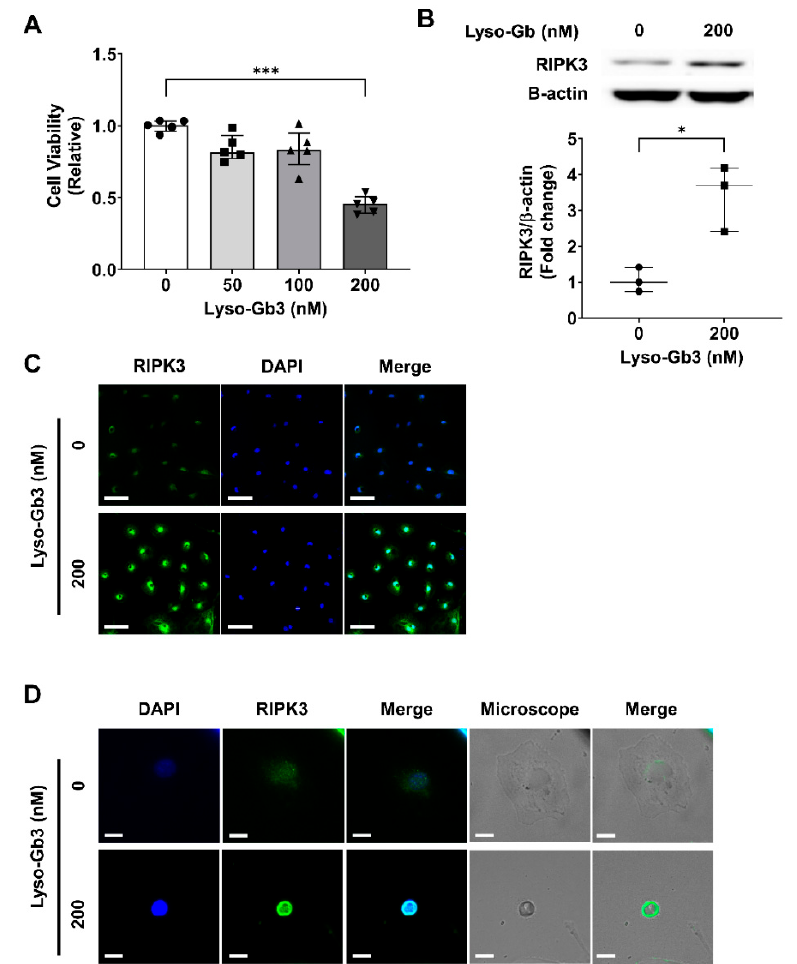
Figure 1. Lyso-Gb3 induced podocyte death via a RIPK3-dependent pathway in mouse podocytes. ( A ) MTT assay for cell viability. Mouse podocytes were treated with lyso-Gb3 for 24 h. Cell viability was reduced significantly in a dose-dependent fashion ( N = 5, median with interquartile range). *** p < 0.001 versus control by the Kruskal–Wallis test with Dunn’s post-hoc analysis. ( B ) Representative Western blot assay ( top ) and densitometric quantification of RIPK3 levels (normalized to β -actin levels) ( bottom ). RIPK3 levels were increased by treatment of Lyso-Gb3 (200 nM) in mouse podocytes ( N = 3, median with interquartile range). * p < 0.05 versus control using the Mann–Whitney test. ( C , D ) Immunofluorescence staining for RIPK3 (green) and DAPI (blue). ( C ) Representative images of RIPK3 expression (green) and DAPI (blue) in podocytes. The number of cells stained with RIPK3 was increased by lyso-Gb3 (200 nM) treatment. Magnification, 20×; Scale bars, 200 μ m. ( D ) Immunofluorescence images obtained with an optical microscope showed that lyso-Gb3 induced cell shrinkage and the expression of RIPK3 in the cytosol. Magnification, 40×; Scale bars, 50 μ m.